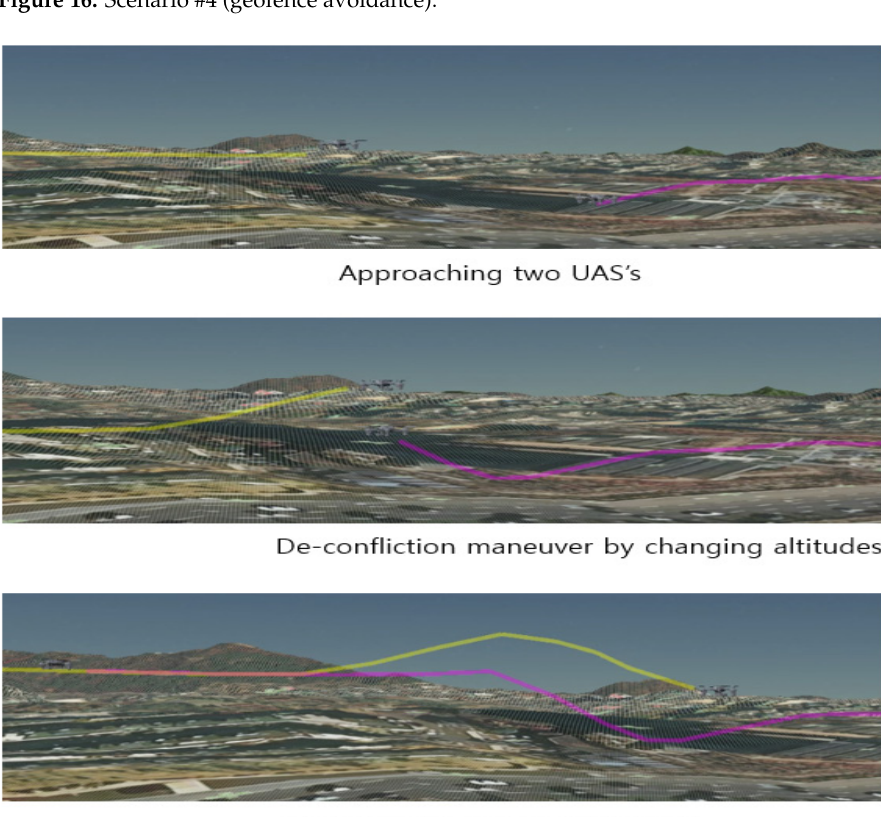
13 of 17 Figure 14. Scenario #2 (deconfliction study by time and altitude).